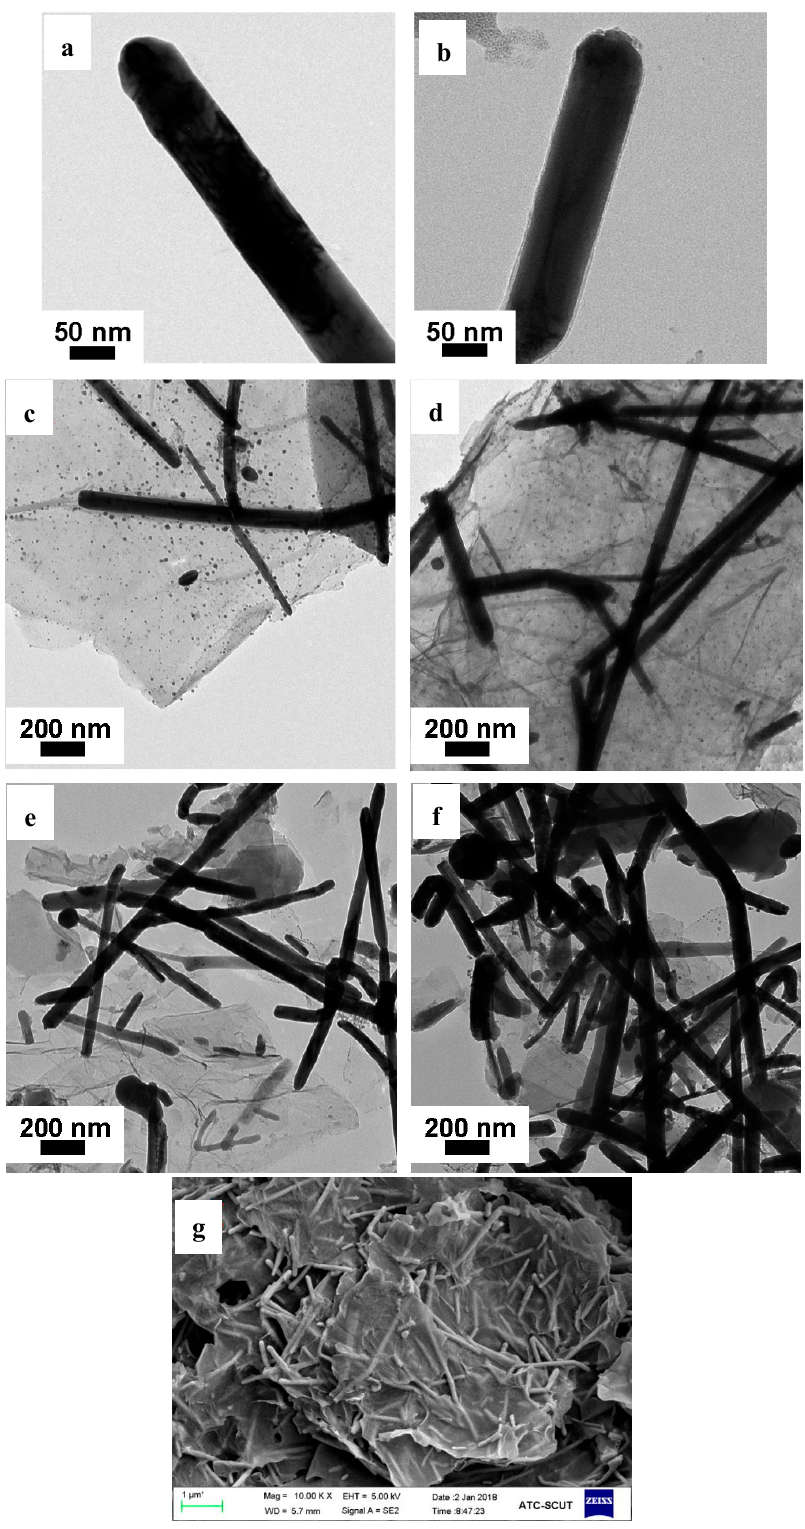
Figure 4. TEM images of the samples: ( a ) AgNWs; ( b ) NH2-AgNWs; ( c ) AgNWs/GNs-1; ( d ) AgNWs/GNs-2; ( e ) AgNWs/GNs-3 and ( f ) AgNWs/GNs-4; SEM images of ( g ) AgNWs/GNs-2.